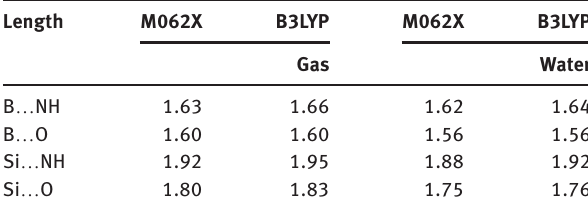
Table 3: Some optimized distances (Å).